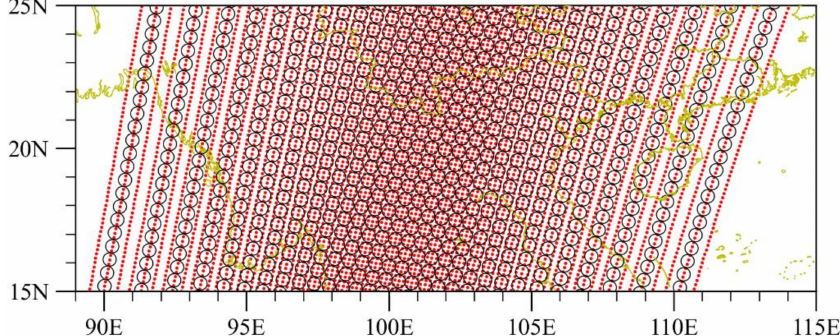
Figure 1. Spatial distribution of the observational position of the AMSU-A (black circles) and MHS (red dots) onboard the NOAA-19 satellite over southeast Asia at 0000 UTC 9 August